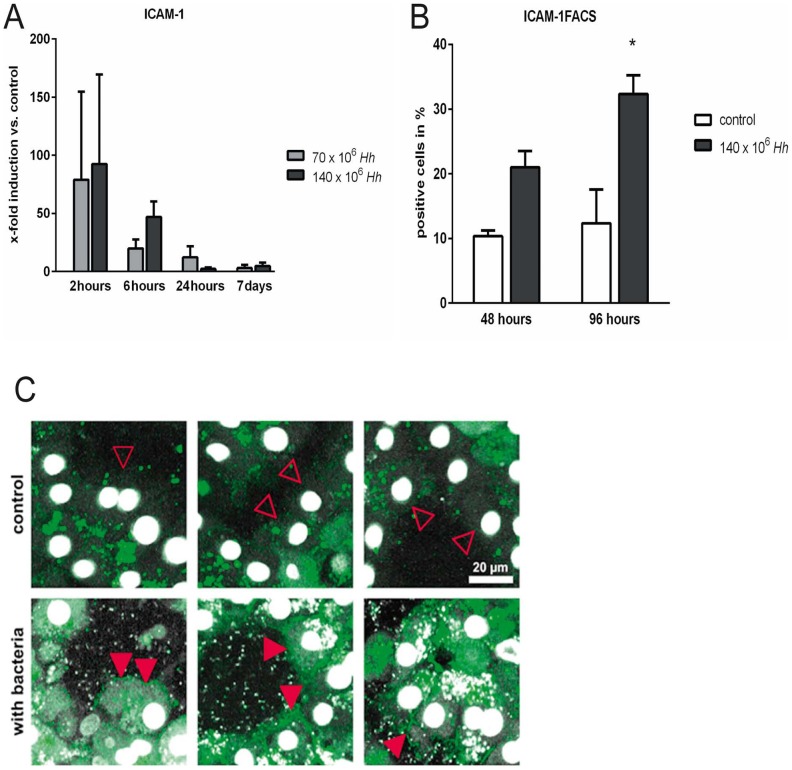
ICAM-1 mRNA expression and ICAM-1 incorporation into primary human hepatocytes (PHH) cell membranes are increased after H. hepaticus exposure.PHH were co-cultured with H. hepaticus at a MOI of 50 (70×106 Hh) or 100 (140×106 Hh) bacteria per hepatocyte (n = 3). (A) Real-time RT PCR of hepatocytes showed increased mRNA expression of ICAM-1 2 and 6 hours after infection. ICAM-1 mRNA expression is displayed as x-fold induction compared to untreated control cultures from the same hepatocyte donor for each time point. (B) PHH were co-cultured with H. hepaticus for 48 and 96 hours at a MOI of 100 per hepatocyte. Subsequently, hepatocytes were harvested, stained with an AlexaFluor488-labeled anti-human ICAM-1 antibody, and analyzed by flow cytometry. Flow cytometry results confirmed an increased incorporation of ICAM-1 into cell membranes of PHH under co-culture conditions with H. hepaticus. * = p<0.05 versus the control culture. (C) After 48 hours of PHH culture in the absence or presence of H. hepaticus at a MOI of 100 per hepatocyte, cell surface staining for ICAM-1 was performed with an AlexaFluor488-labeled anti-human ICAM-1 antibody (green). H. hepaticus and hepatocyte nuclei were stained with DAPI (white). Representative snapshots are shown taken from two-photon microscopy time lapse recordings of PHH cultures in the absence (control, upper row) or presence (with bacteria, lower row) of H. hepaticus (n = 3). Aquisition settings (TiSa laser tuned to 760 nm, 485 nm long pass filter, no bandpass filters) and snapshot image processing were identical for all recordings. While surface ICAM-1 staining was virtually absent in control cultures (open red arrow heads), PHH cultivated in the presence of H. hepaticus displayed a marked ICAM-1 expression on the cell surface (filled red arrow heads).